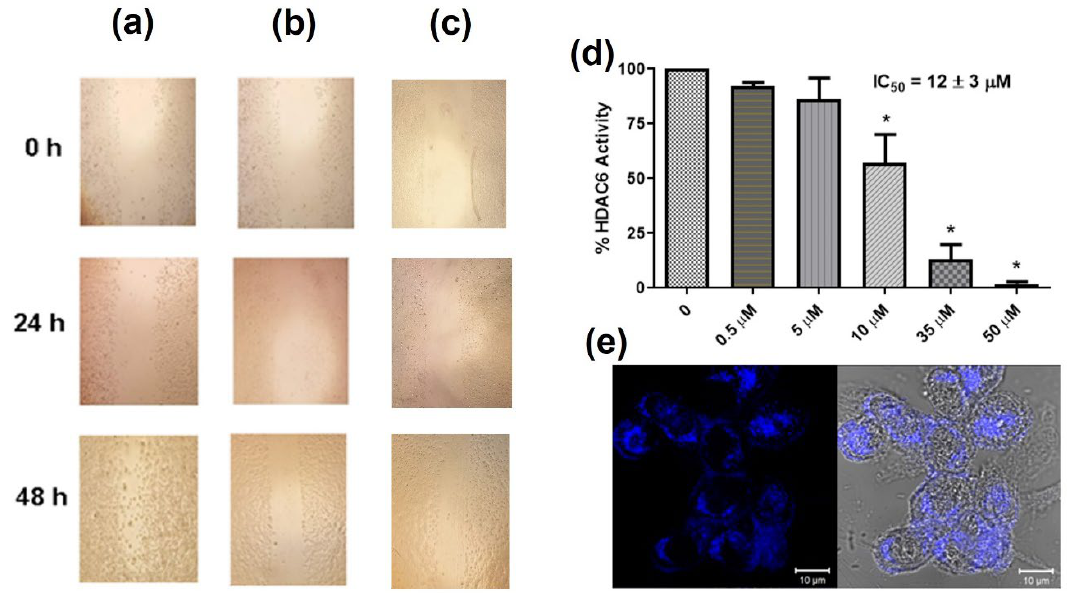
Figure 5. In vitro wound closure cell migration assay with the BC cell line MDA-MB-231 at 0, 24, and 48 h of incubation. ( a ) Control, ( b ) compound 2b, and ( c ) compound 2c at 15 µM concentration. ( d ) Dose-dependent curve of HDAC6 inhibition by compound 2b . Data represent mean ± SEM [* significantly different from AA ( p < 0.05)]. ( e ) Confocal microscopy images, MCF-7 cells exposed to compound 2b at a concentration of 10 µ M: increased resolution of lasser (left) and low-resolution image